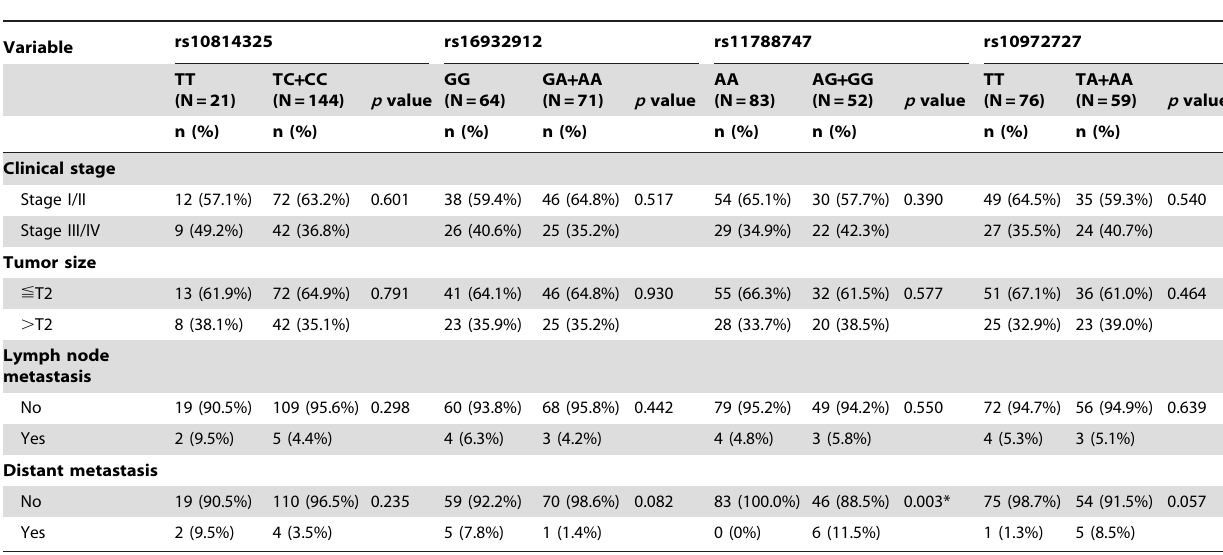
Table 4. Clinical TNM staging and RECK genotypic frequencies in 135 HCC